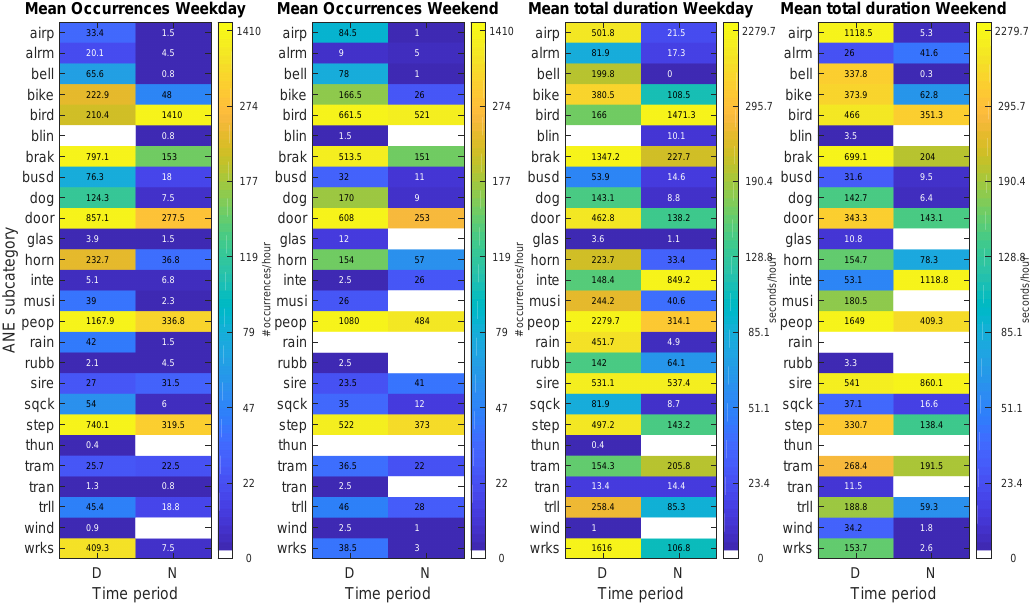
Figure 4. Results of the day–night analysis ( P DN matrices) differentiating weekday and weekend days for the following ANE features: mean number of occurrences per hour (two leftmost subfigures) and total duration per hour (two rightmost figures). Each subfigure shows the distribution of the corresponding ANE feature in terms of ANE subcategory and time